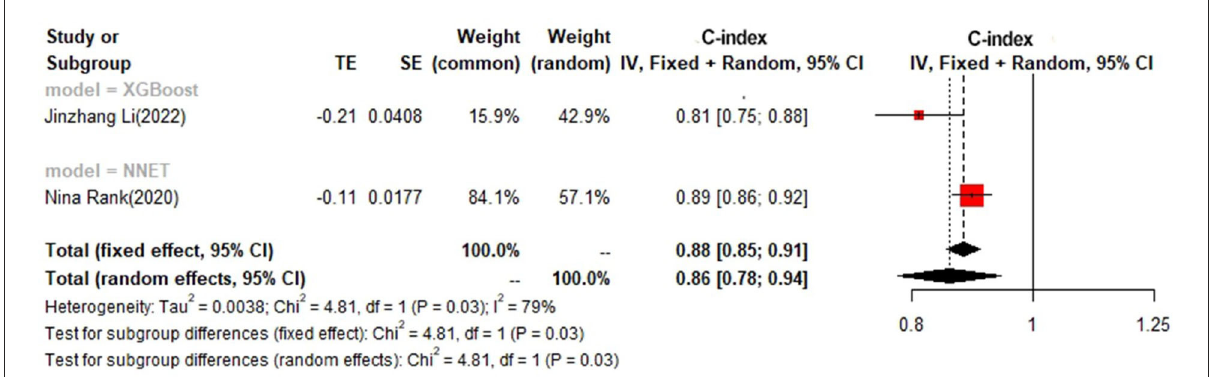
FIGURE10 C-index in the test set: other